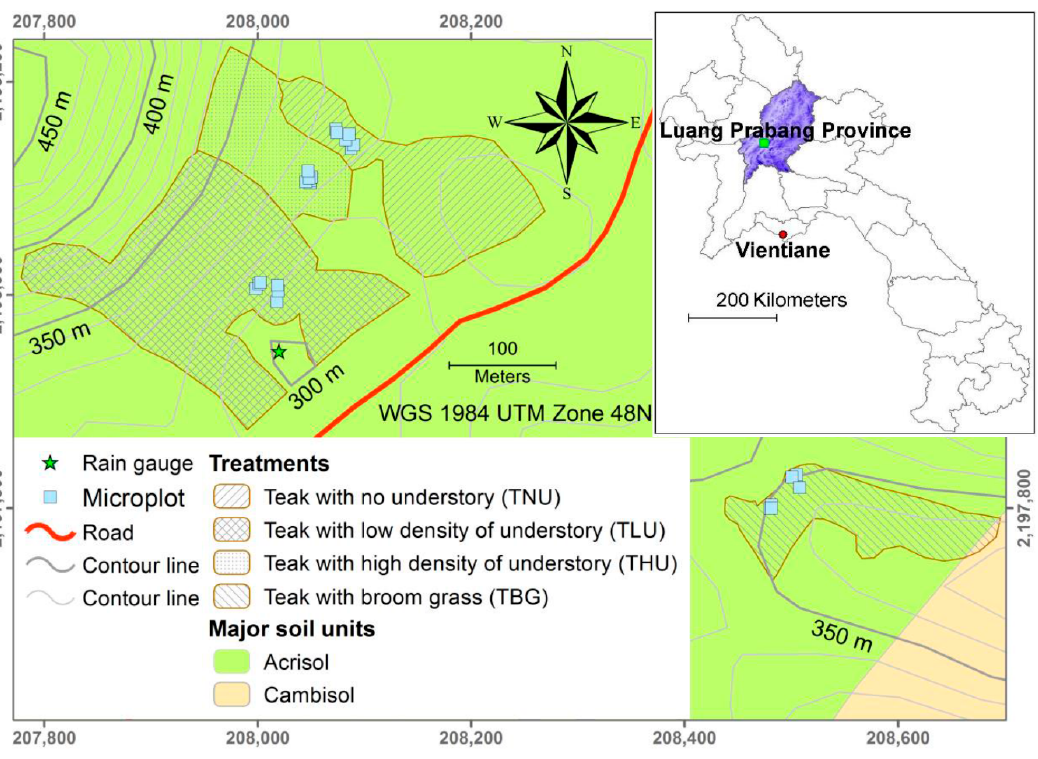
Figure 1. Study site in Ban Kokngew, Luang Prabang Province, Lao People’s Democratic Republic, with location of experimental microplots, treatments, and soil types.